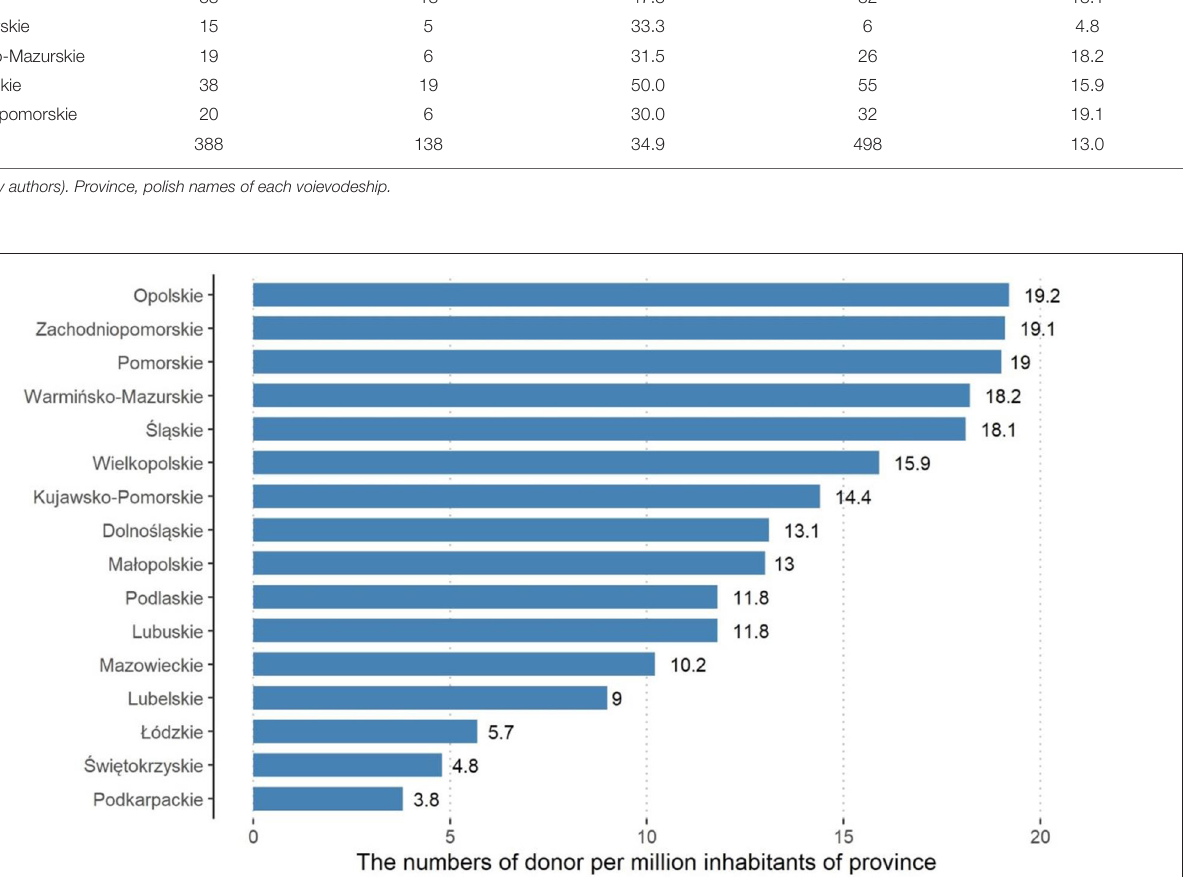
of the linear relationship between the observed measurements of the quantitative feature and their values resulting from the predictions of this model.